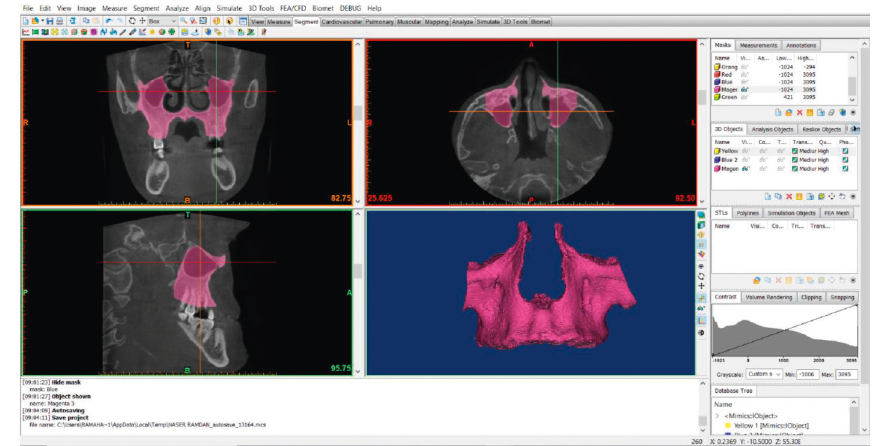
Figure 5: The solid final maxillary